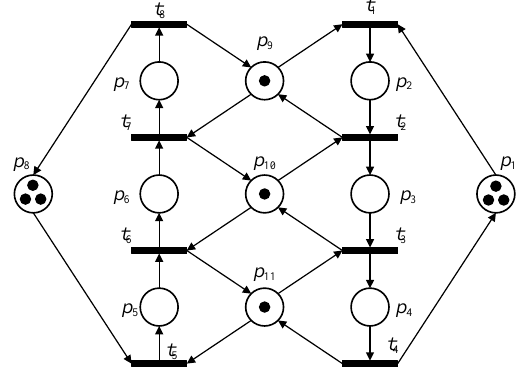
Figure 2. A Petri net model of flexible manufacturing systems (FMS). M 1